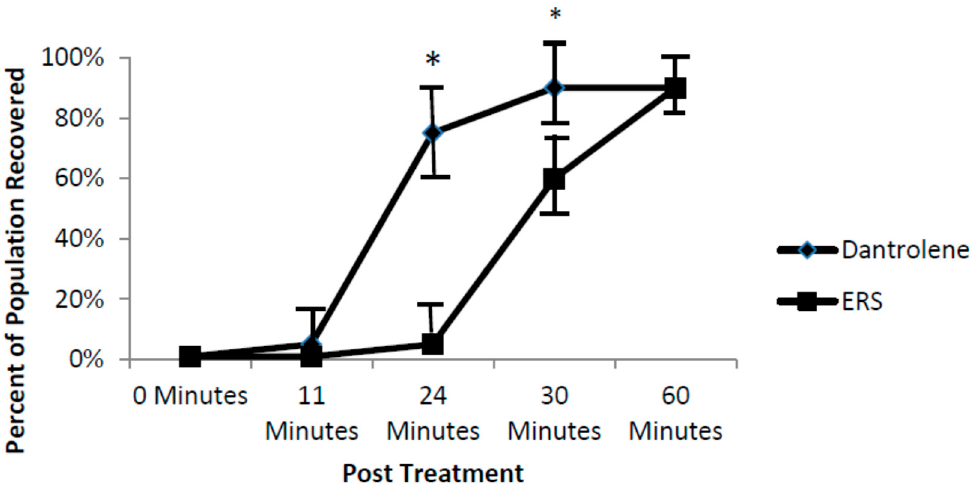
Figure 6. The effects of ERS and dantrolene (10 μ M) washout on the recovery of arrhythmic fish previously treated with nNOSI. Note that by 24 min after washout approximately 75% of dantrolene treated fish had recovered from the arrhythmic phenotype while in ERS treated fish recovery was insignificant ( p < 0.001). By 30 min after ERS washout, although approximately 60% of the fish had recovered from the arrhythmic phenotype, they were still significantly behind the 90% recovery for the dantrolene treated fish ( p < 0.05). However, by 60 min after washout, both treated fish group HRs had returned to normal heart rate levels. Bars = ± SD. Asterisk indicates significant differences between both 24 and 30 min measures.